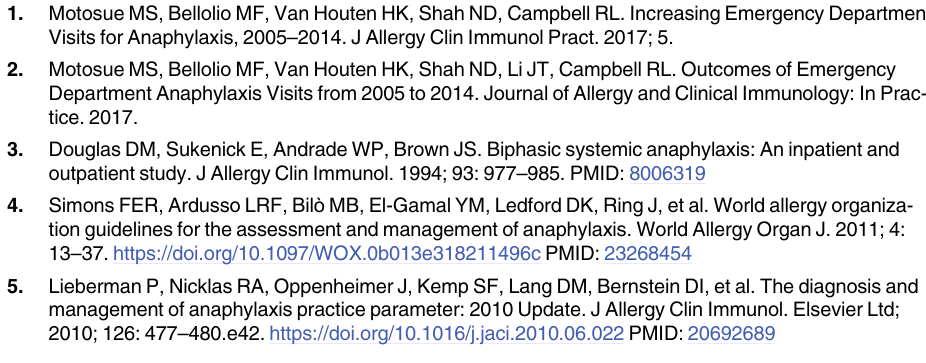
S1 Table. Clinical criteria for diagnosing anaphylaxis